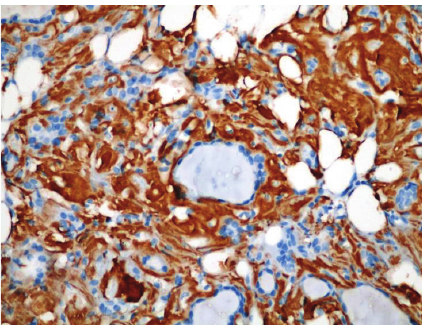
Figure 2: Immunohistochemical method to stain amyloid (400x).